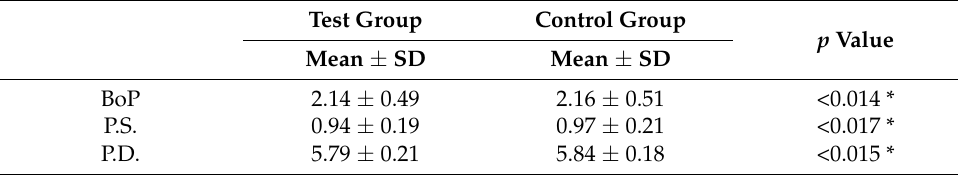
Table 7. Peri-implant parameters among test group and control group pre-treatment. Test Group Control Group p Value Mean ± SD Mean ± SD BoP 0.71 ± 0.14 0.32 ± 0.12 <0.0008 * P.S. 0.03 ± 0.05 0.03 ± 0.02 0.002 P.D. 3.85 ± 0.12 2.23 ± 0.21 <0.0009